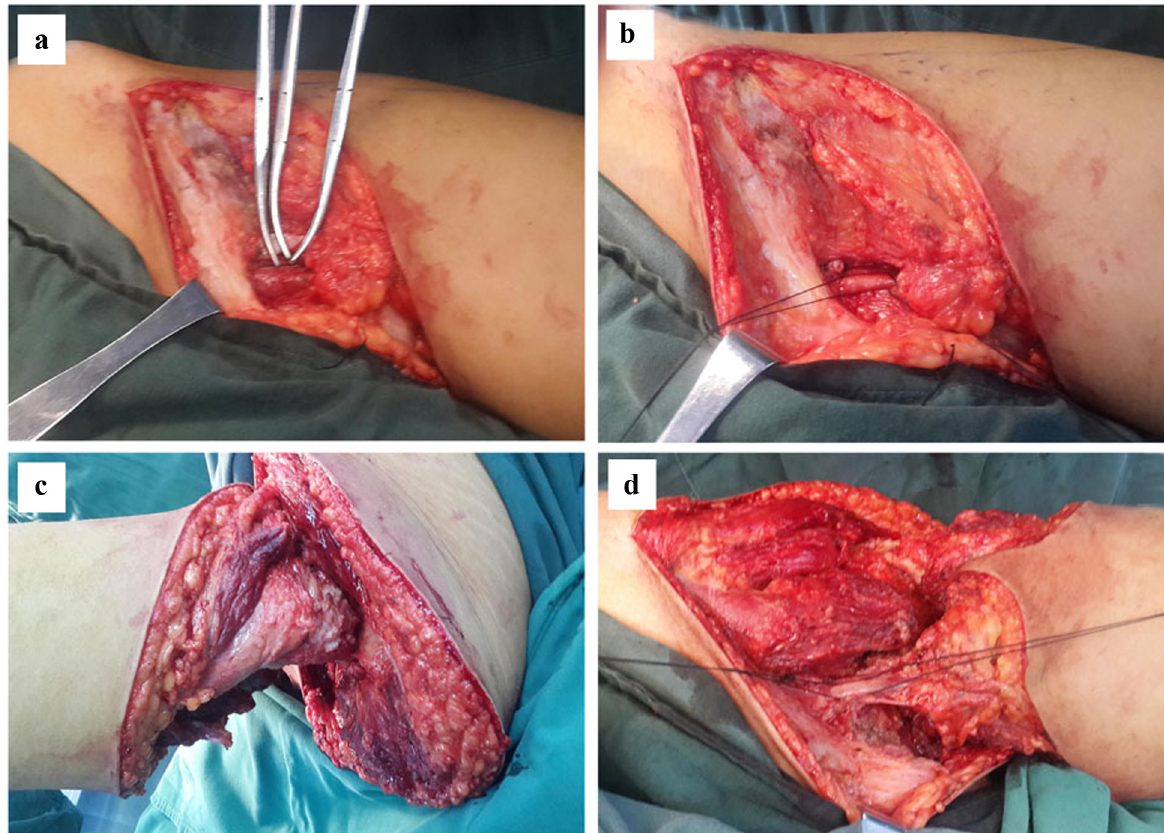
Figure 2: Process of hip disarticulation with delayed femoral vein ligation for the left leg. ( a ) The exposed main artery was occluded fi rst using a double ligation technique. ( b ) Both the ligature and sheath of the main vein were reserved. ( c ) The muscle and fascia were then split, and the backbone and joint capsule of the truncated bone were exposed. ( d ) Finally, the main vein was ligated, and the distal limb was